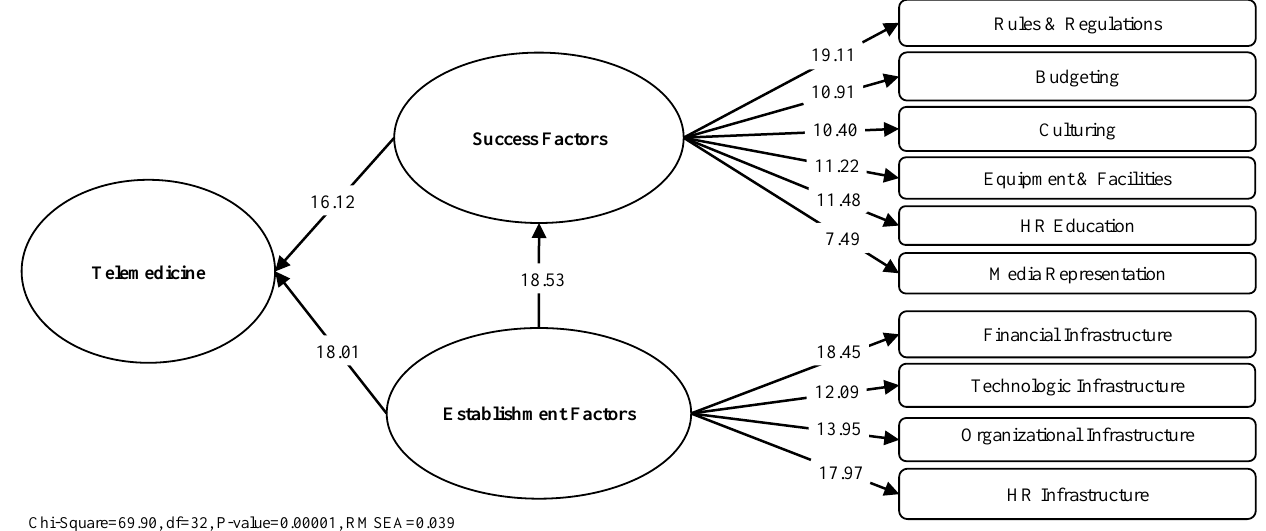
Figure 2. Fitness of the conceptual model-structural part